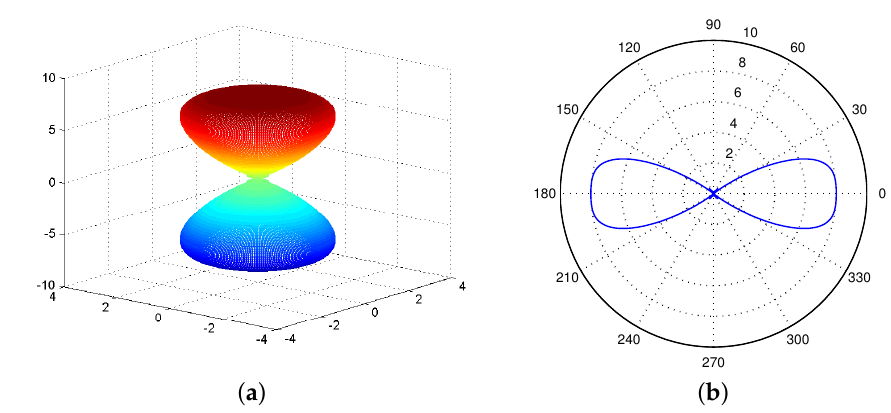
Figure 5. Radiation pattern of a ULA antenna. ( a ) In 3D space; ( b ) on a 2D